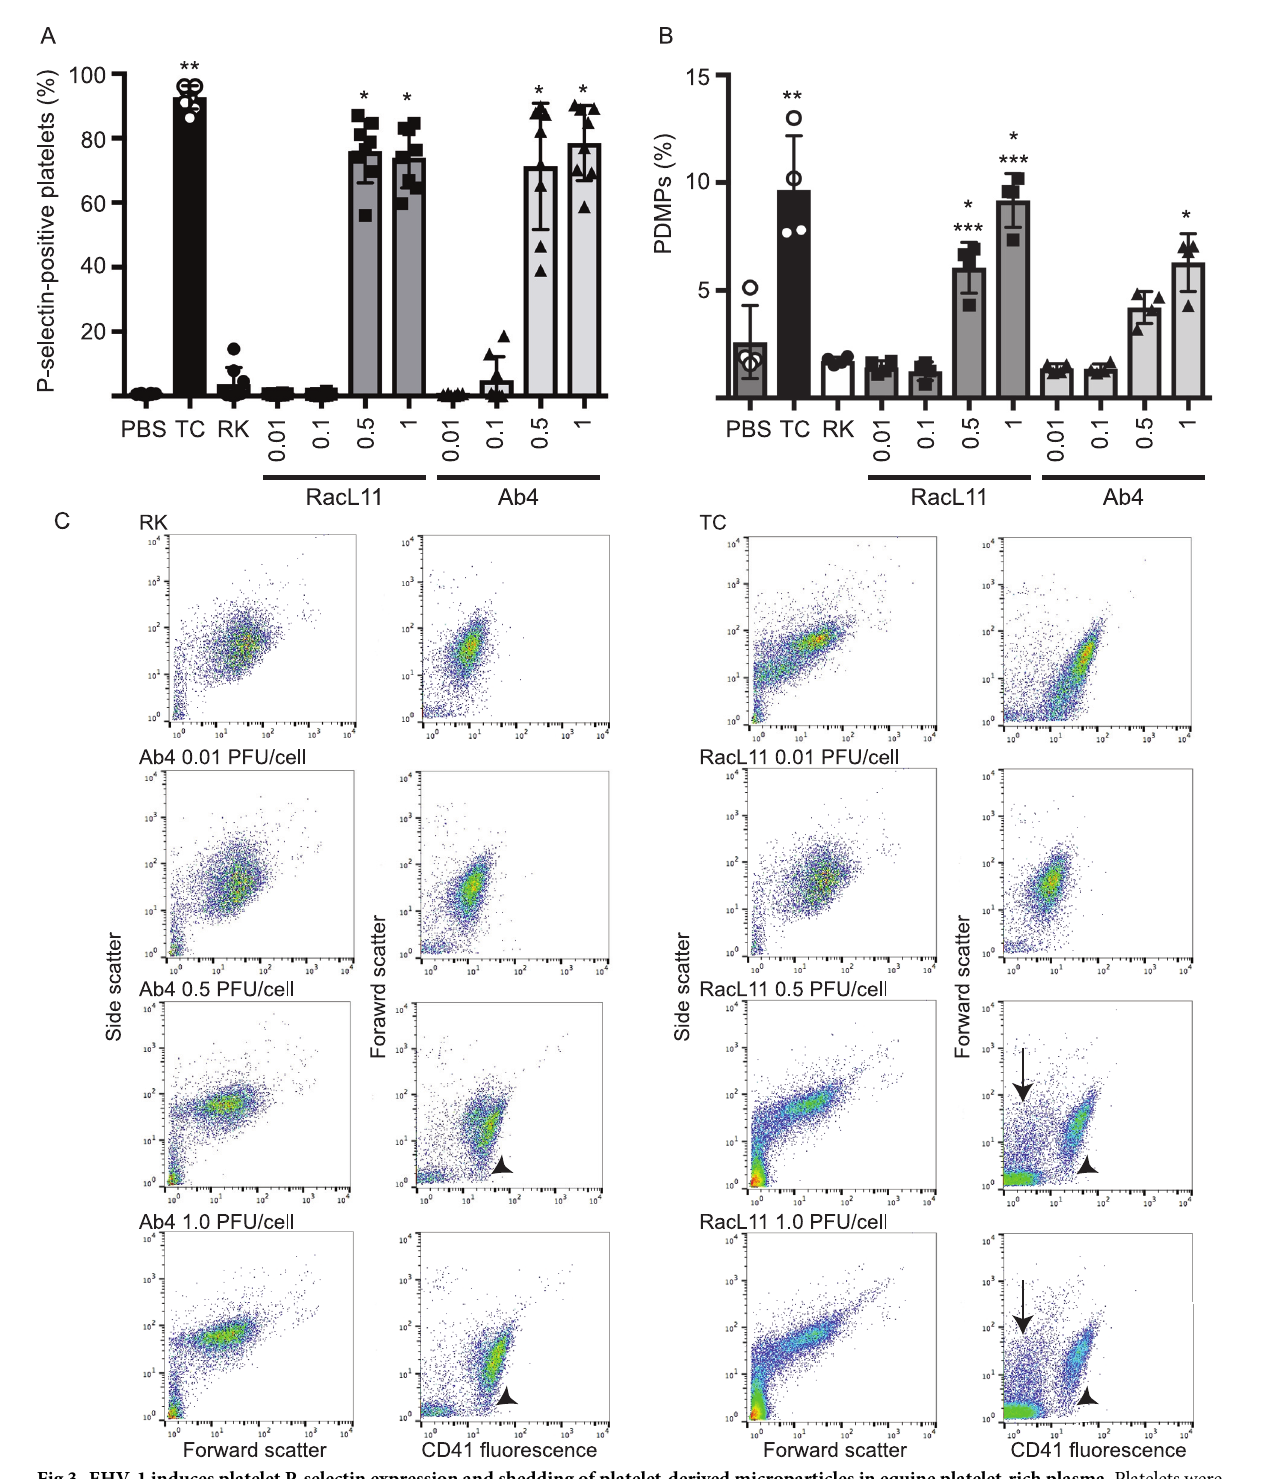
Fig 3. EHV-1 induces platelet P-selectin expression and shedding of platelet-derived microparticles in equine platelet-rich plasma. Platelets were exposed for 10 minutes to RacL11 or Ab4 EHV-1 strains at increasing PFU/cell (0.01, 0.1, 0.5, or 1) with PBS and RK lysate as negative controls and thrombin-convulxin (TC, 0.15 U/mL-0.05 ug/mL) as a positive control. Then the mean percentage ± SD of platelets positive for P-selectin ( A , n = 8) and PDMPs ( B , n = 4) were quantified. At the higher PFU/cell of 0.5 and 1, both strains induced P-selectin expression and microvesiculation. Dotplots of forward versus side scatter ( C , left panels) and CD41 fluorescence versus forward scatter ( C , right panels) for RK lysate, TC and both viruses show that, at the higher PFU/cell of 0.5 and 1, both strains caused compaction and narrowing of the platelet event cloud and increased CD41-positive small